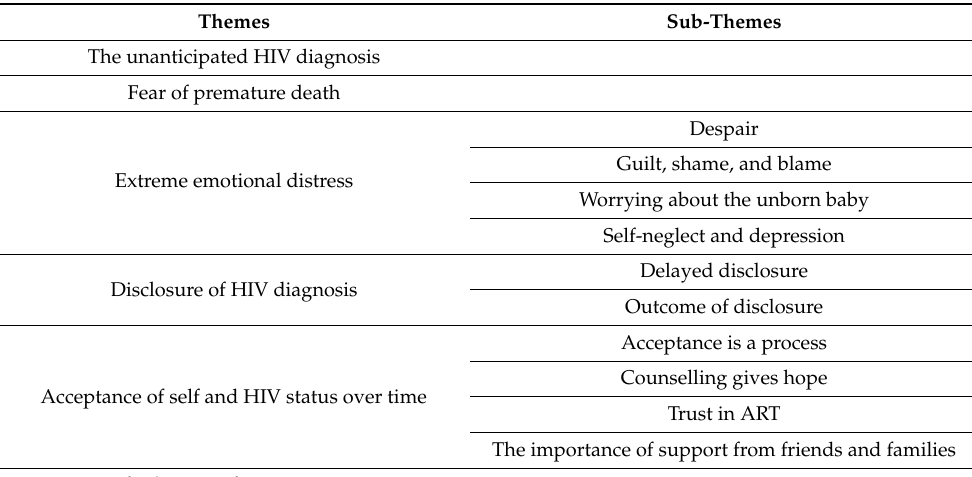
Table 1. Summary of